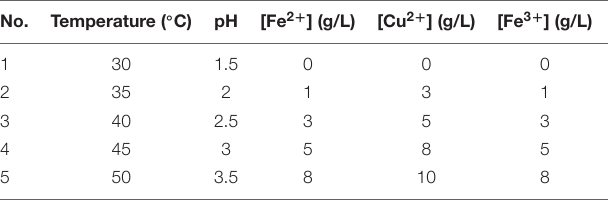
TABLE 1 | Headers of the five-factor and five-level orthogonal